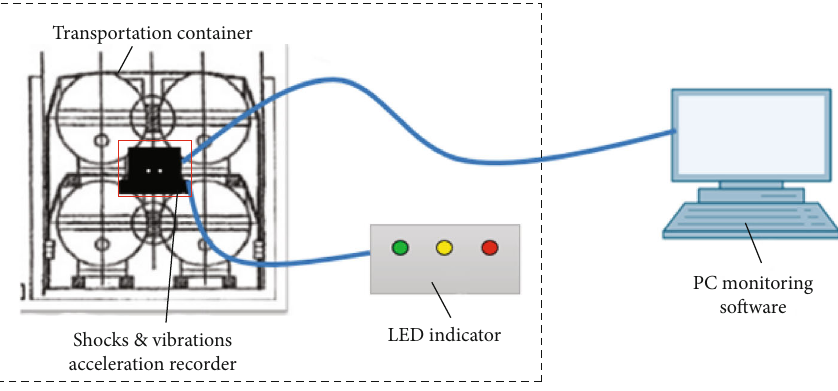
Figure 1: Schematic diagram of system working process. Table 1: Main chip power